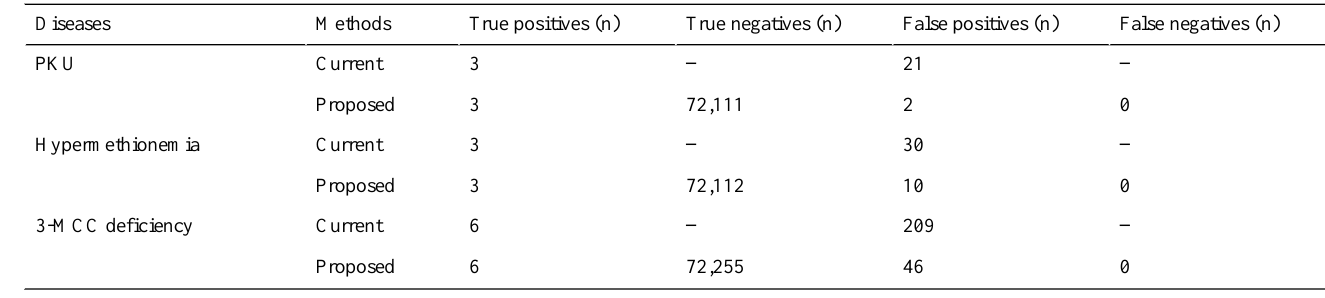
Table 4. Comparison of the current method versus the proposed method. The numbers are obtained from predicting the neonatal